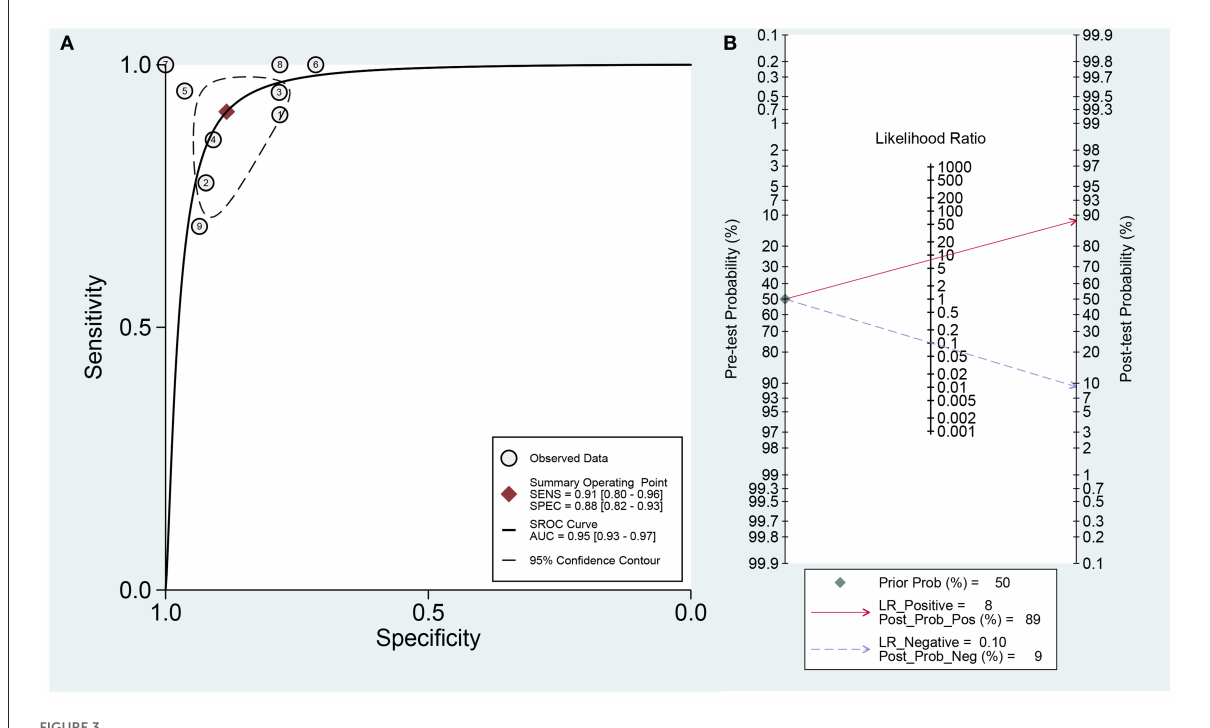
FIGURE3 (A) The area of curve (AUC) of Summary receiver operating characteristic (SROC) curve. (B) Fagan’s nomogram for assessing post-test probabilities of